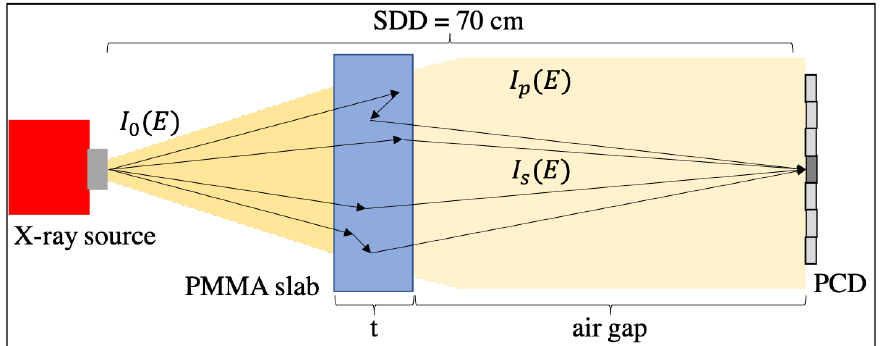
Figure 1. Schematic of experiment configuration.